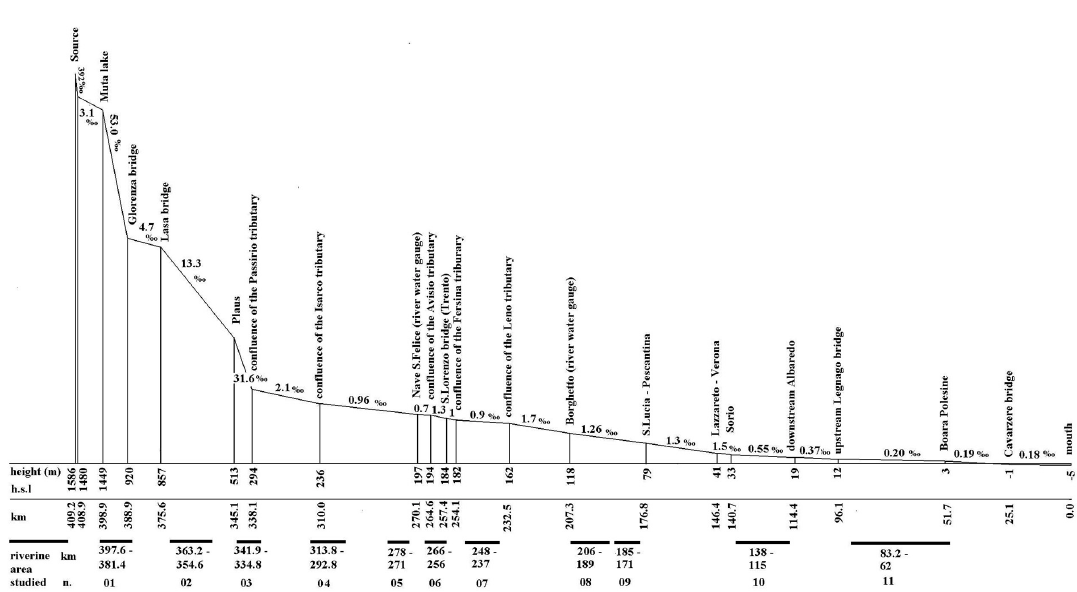
FIGURE 2. The Adige River. Location of the 11 areas of the fluvial corridor inventoried along the altitude-slope line (modified from [12]). AREA OF